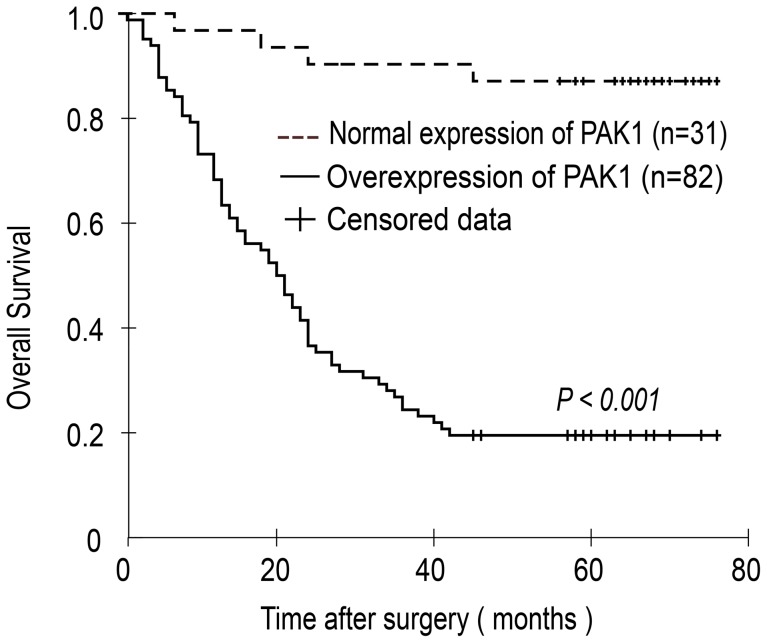
Relationship between overall survival and PAK1 expression.Kaplan-Meier analysis shows PAK1 overexpression was significantly associated with shorter overall survival for patients with GEJ adenocarcinoma.